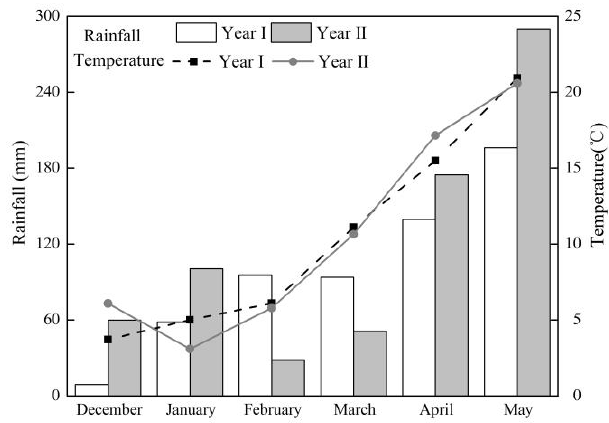
Figure 1. Monthly precipitation (mm) and average air temperature (°C) at the experiment site from December to May in cropping Year I (from 2014 to 2015) and Year II (from 2015 to